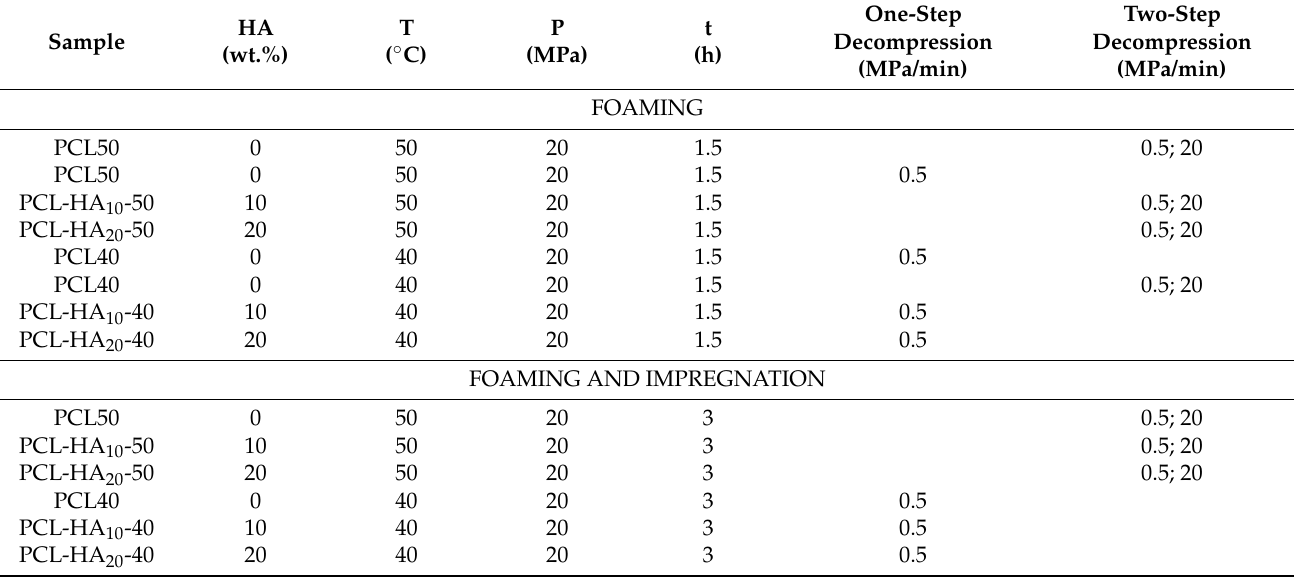
Table A1. Summarized experimental conditions.